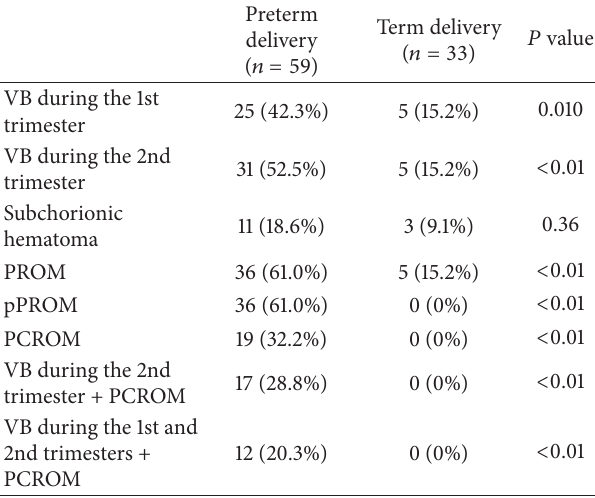
Table 4: Comparison of pregnancy outcomes between preterm and term delivery subgroups of circumvallate placenta